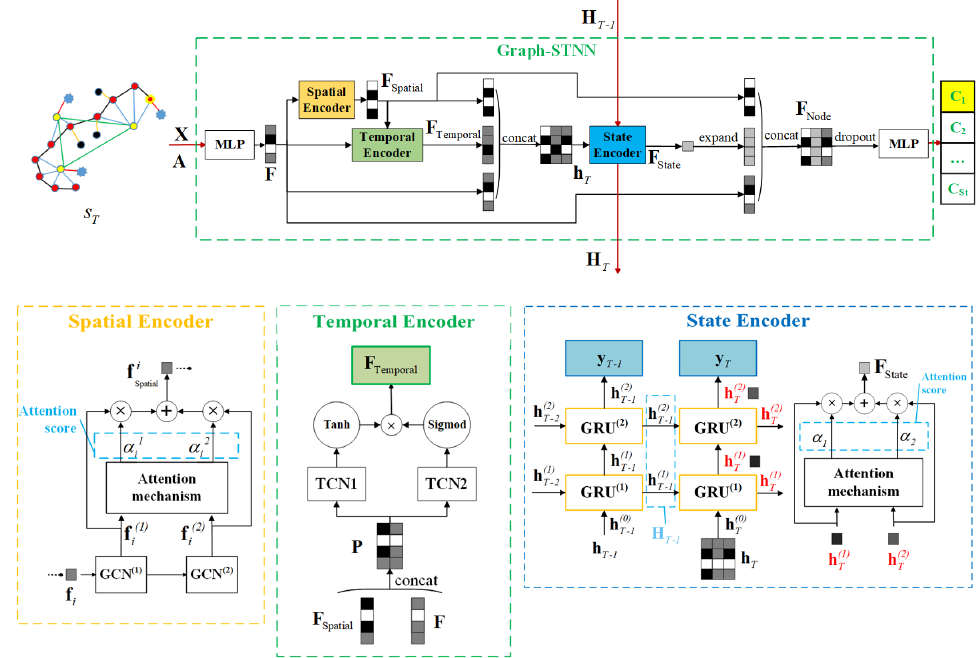
Figure 3. The structure of Spatiotemporal Neural Network on Graph (Graph-STNN). The current state is represented as the exploration graph s T . All frontier waypoints can be represented as C 1 ∼ C st , in which st is the number of frontier waypoints in the current state. The inputs of the network are an adjacency matrix A and an original node feature matrix X of the exploration graph. First, the original features encoded by a multi-layer perceptron (MLP), the spatial features extracted by the spatial encoder, and the temporal features extracted by the temporal encoder are concatenated together. Then, the concatenated feature is input to the state encoder to obtain the state feature, which is the same for each node. Finally, the state feature combined with the original features and spatial features is input to a liner layer after dropout, and the output is the value of each frontier waypoint. The frontier waypoint with the largest value is the local target